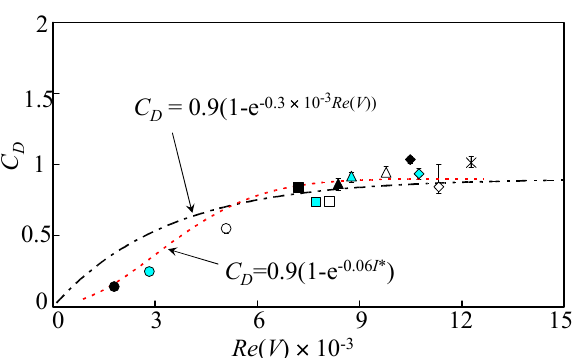
Fig. 18 Drag coefficient C D versus Reynolds number Re ( V ) based on a theoretical descent velocity V , for several values of inertia-moment ratio I * at depth-to-width ratio λ = 0.3, aspect ratio AR = 10, C = 3.86 × 10 2 .